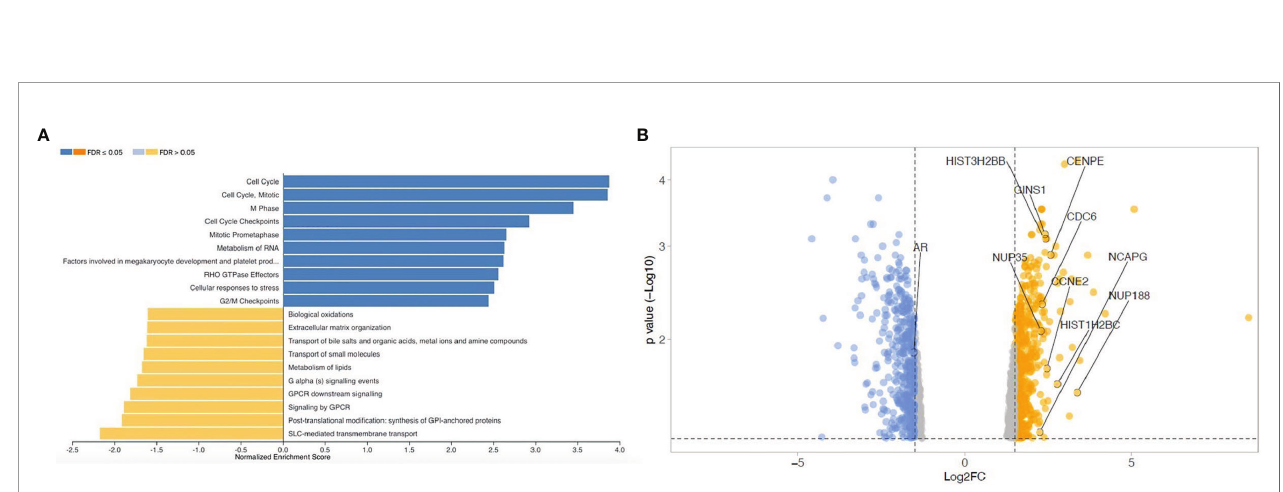
FIGURE 1 | Gating strategy for C4-2B cell cycle. Cells are stained with FVD to exclude death cells (FVD+). Gating strategy based on Forward and Side scatter is